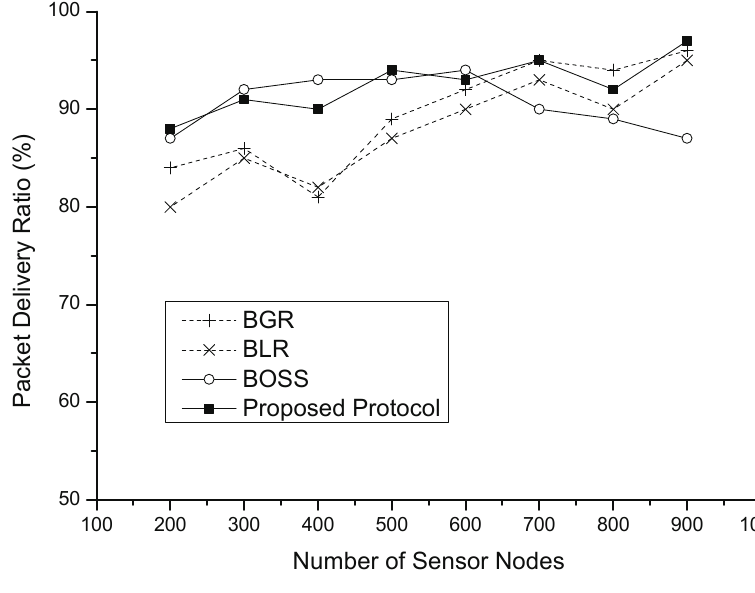
Figure 11. The packet delivery ratio vs. the number of sensor